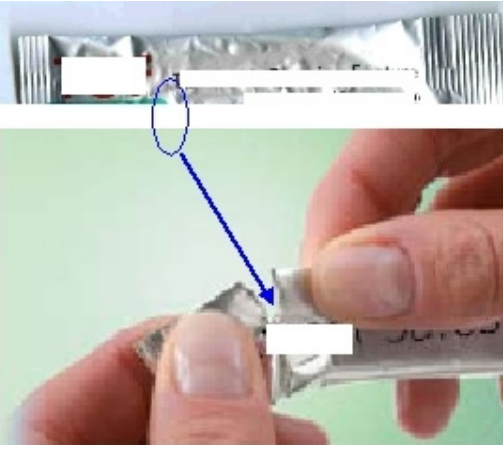
Figure 9. Child-resistant SafeStick TM tear-open pack